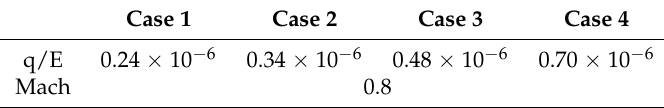
Table 6. Aeroelastic analysis envelope for the HiReNASD